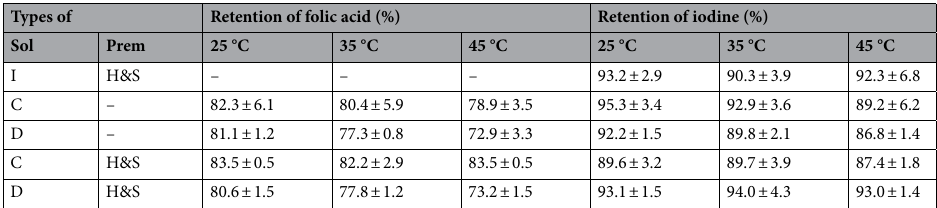
Table 3. Stability of folic acid and iodine in T after 6-month storage. Sol. = solution: C = 0.5% folic acid + 2% iodine, D = 1% folic acid + 2% iodine, and I = 2% iodine. Prem. = iron premix: H&S = iron premix coated with 5% HPMC and 5% soy stearin.